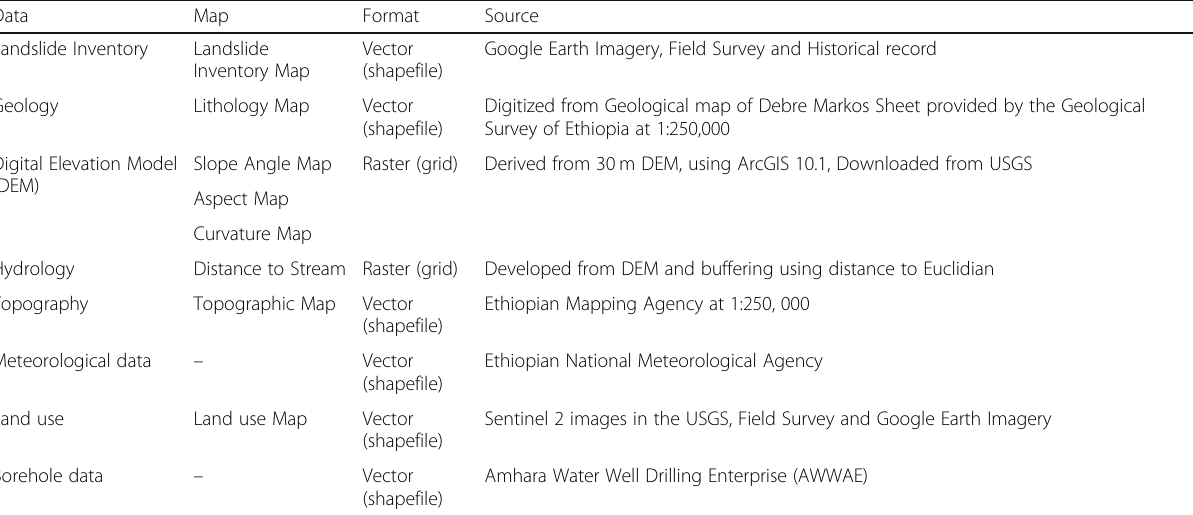
Table 1 Unknown switch argument. Information source for the various landslide factors used in the landslides susceptibility